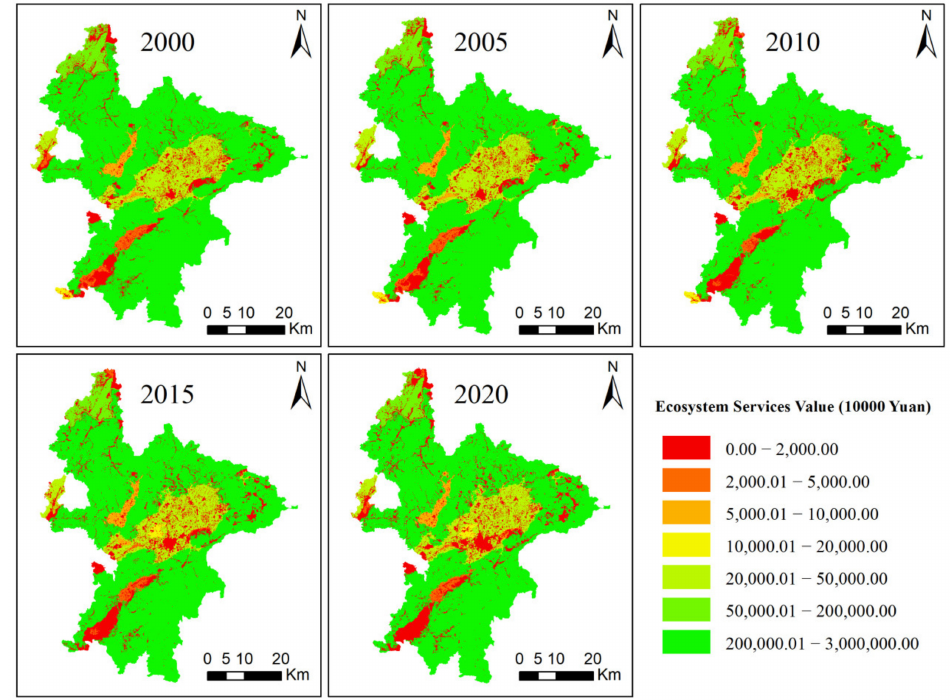
Figure 5. Spatial distribution of the ecosystem service values in Ruijin City from 2000 to